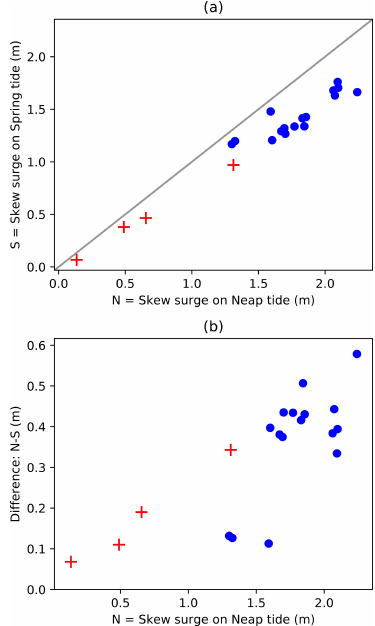
Figure E1. (a) Skew surge realized on spring tide (“S”, Y axis) vs. skew surge realized on neap tide (“N”, X axis). (b) Differ- ence (N–S) vs. N. Blue dots show our experiments using atmo- spheric forcing from the 16 most extreme Sheerness events in the HadGEM3-GC3-MM simulation. Red crosses show data from Williams et al.